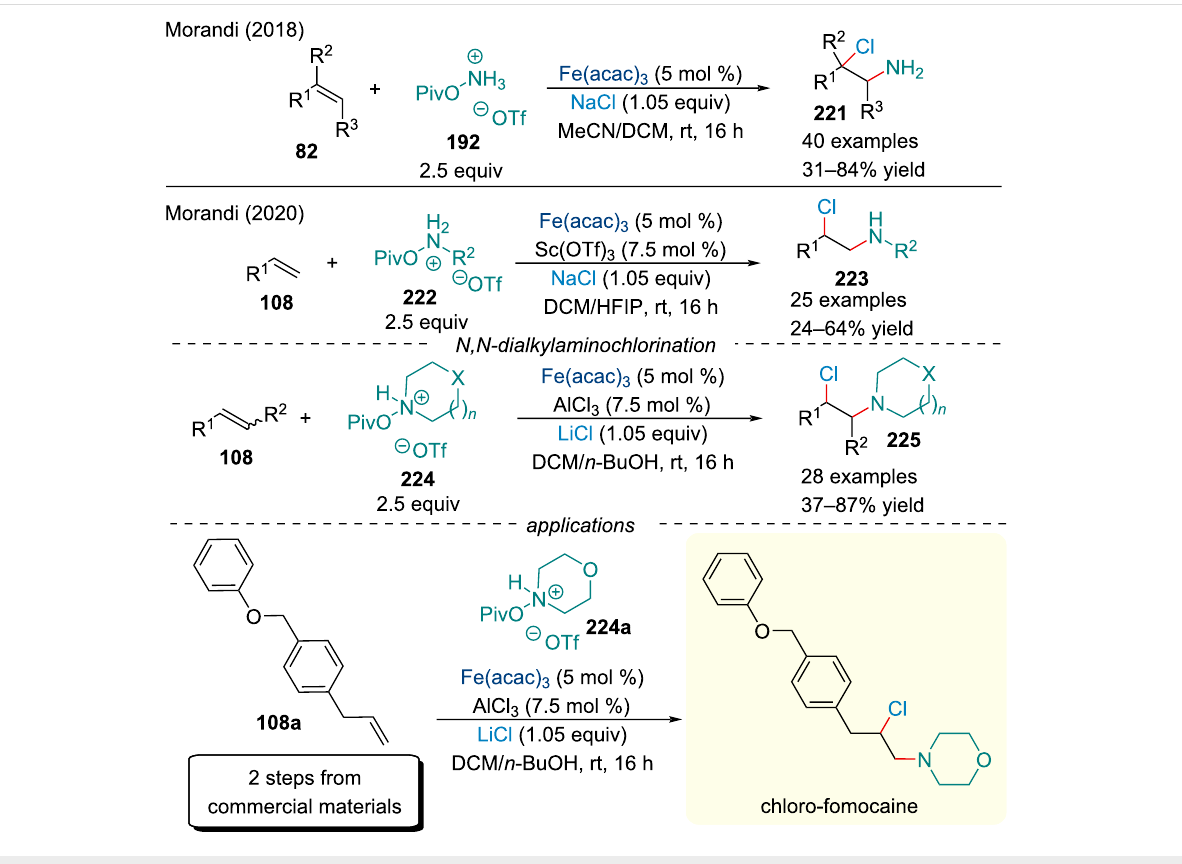
Scheme 51: Iron-catalyzed aminochlorination of alkenes 82 .